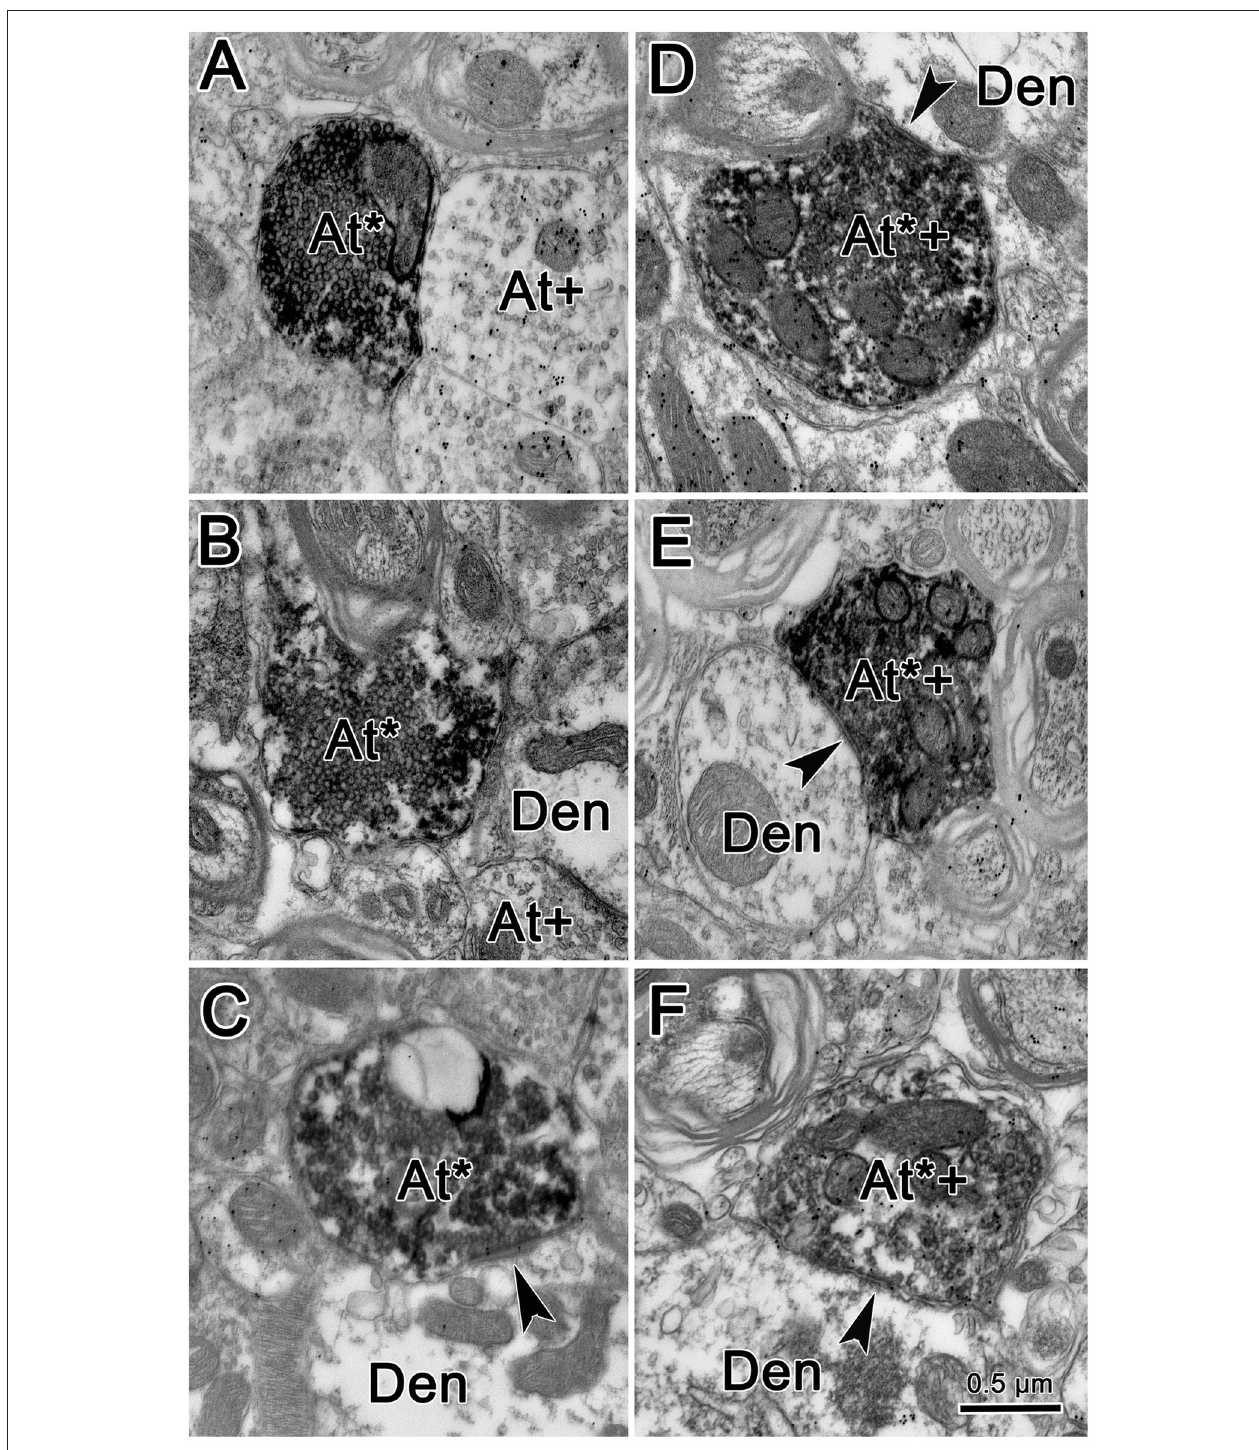
FIGURE 8 | Ultrastructure of reticuloreticular axon terminals. Axon terminals that were labeled with BDA (At ∗ ) following the injection of the cMRF shown in Figure 7 were electron dense. Most of these terminals contacted (arrowheads) small dendrites (Den). These labeled terminals were heterogeneous: some were packed with clear spherical vesicles (A–C) and displayed asymmetric synaptic densities (C) . Others contained pleomorphic vesicles and made symmetric contacts (D–F) . Postembedding immunohistochemistry for gamma-aminobutyric acid (GABA) labeled a portion of the BDA labeled axon terminals (At ∗+ ), as well as some terminals not labeled with BDA (At + ). The BDA labeled terminals that were overlain with numerous gold particles indicating they were GABAergic contained pleomorphic vesicles and made symmetric synaptic contacts (D–F) .